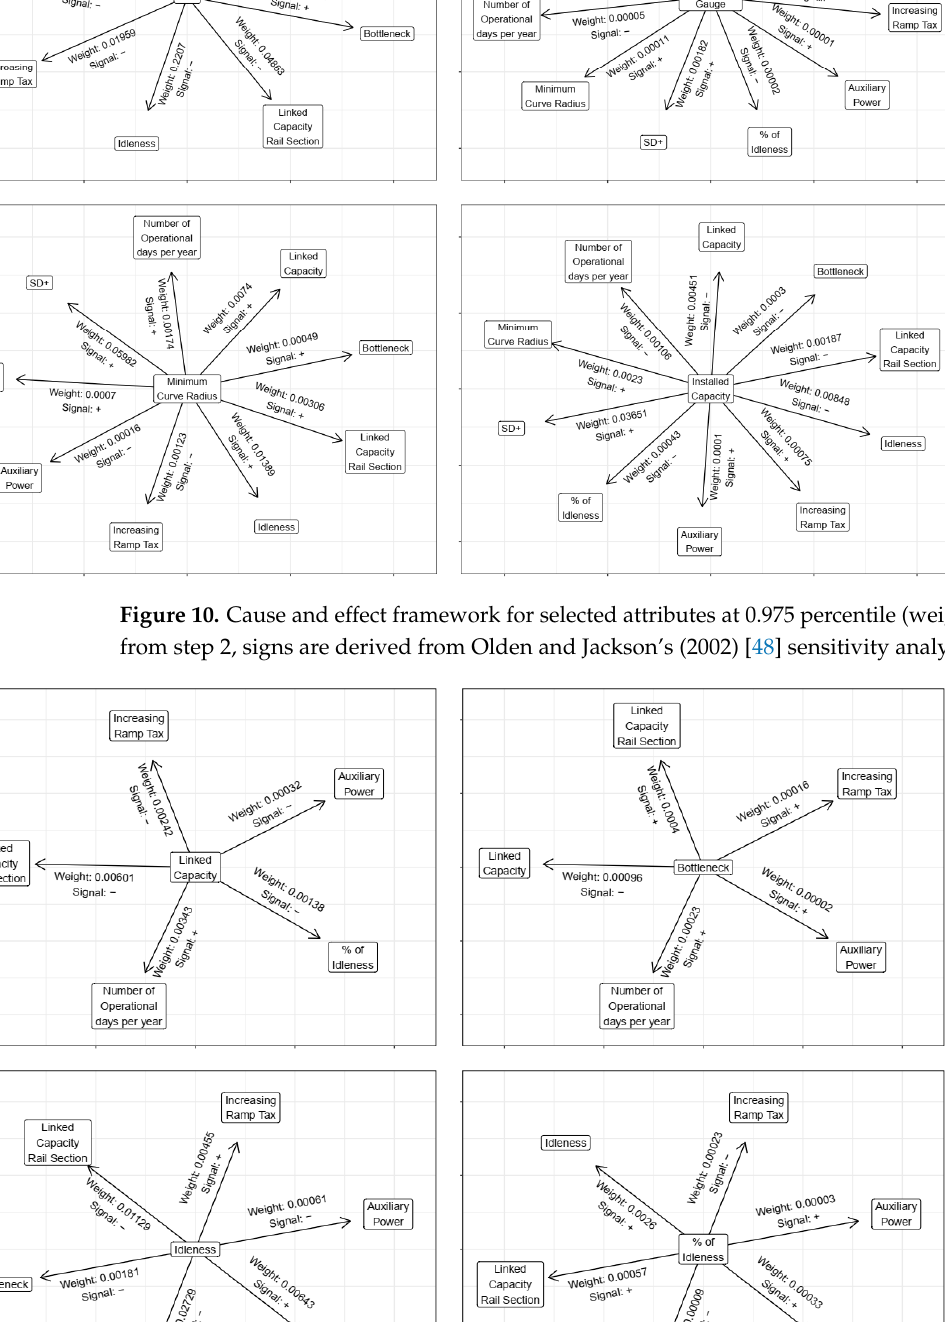
Figure 12. Cause and effect framework for selected attributes at 0.975 percentile (weights are derived from step 2, signs are derived from Olden and Jackson’s (2002) [48] sensitivity analyses).